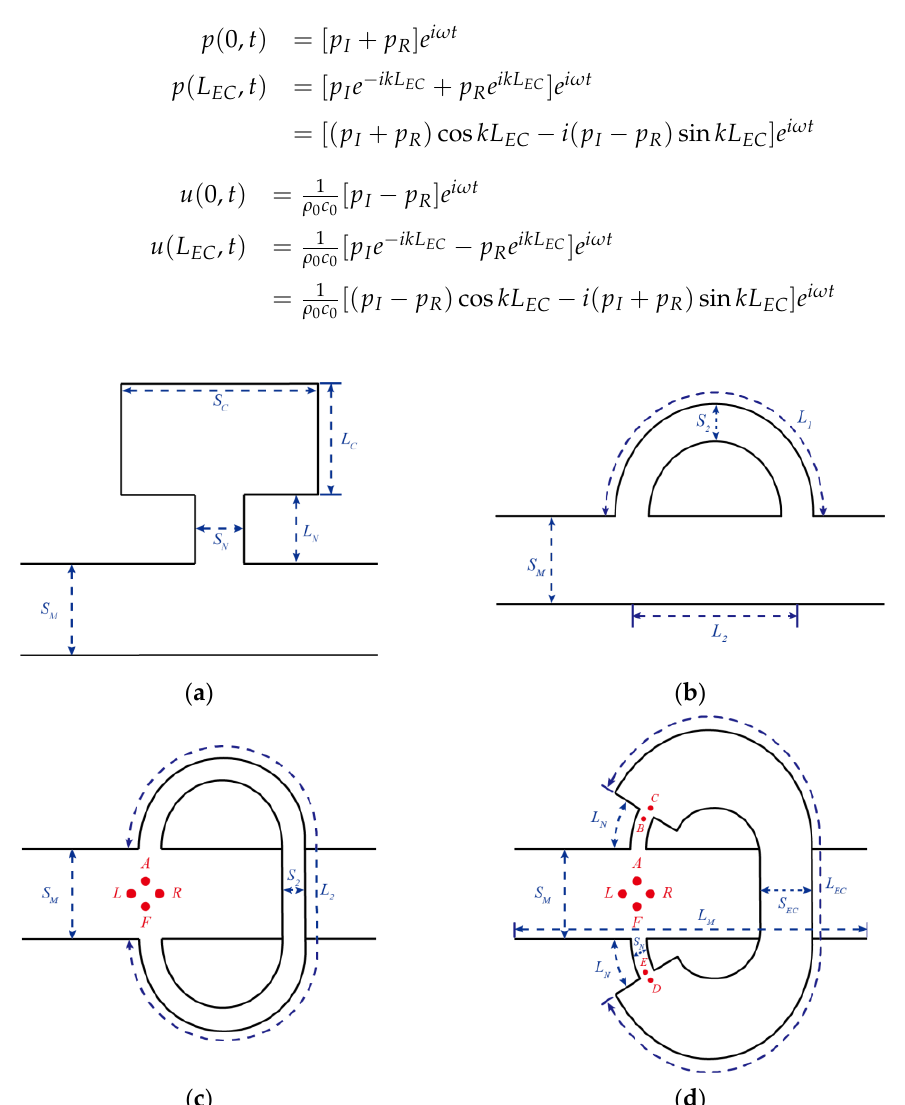
Figure 1. Schematic of the Helmholtz resonator, HQ tube, infinity tube, and infinity tube with an expansion chamber. ( a ) Helmholtz resonator (HR); ( b ) HQ tube; ( c ) infinity tube (IT); ( d ) infinity tube with an expansion chamber